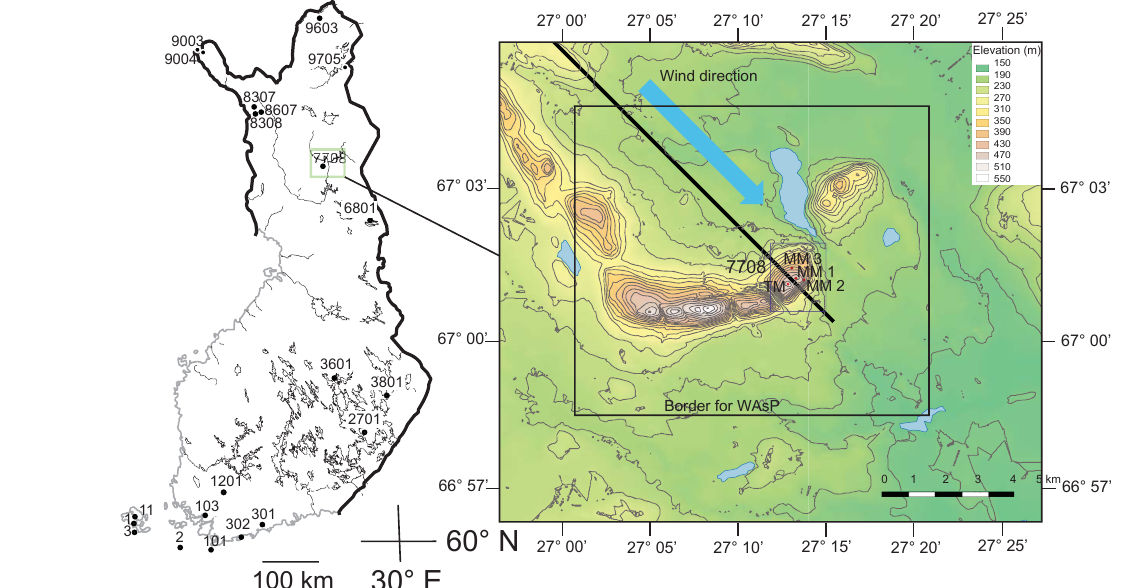
Figure 5. The meteorological stations used in the analyses (see Table 1, Fig. 6) and the topography of the Pyhätunturi area located in northern Finland. The black northwest direction line in the Pyhätunturi figure indicates the transection analyzed in Fig. 4; the black square indicates the border of the WAsP